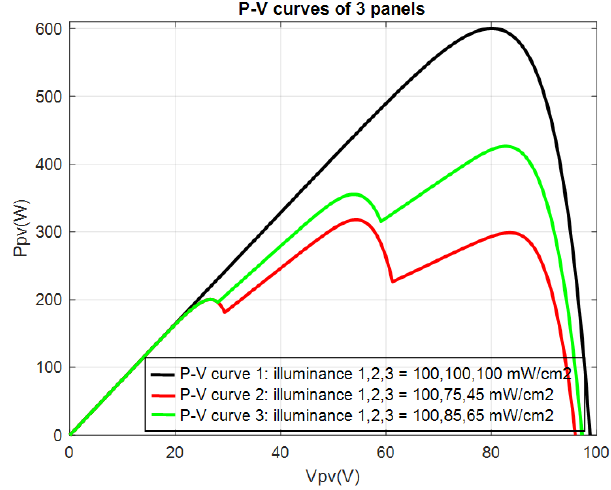
Figure 2. P-V curves of three PV power panels in series.